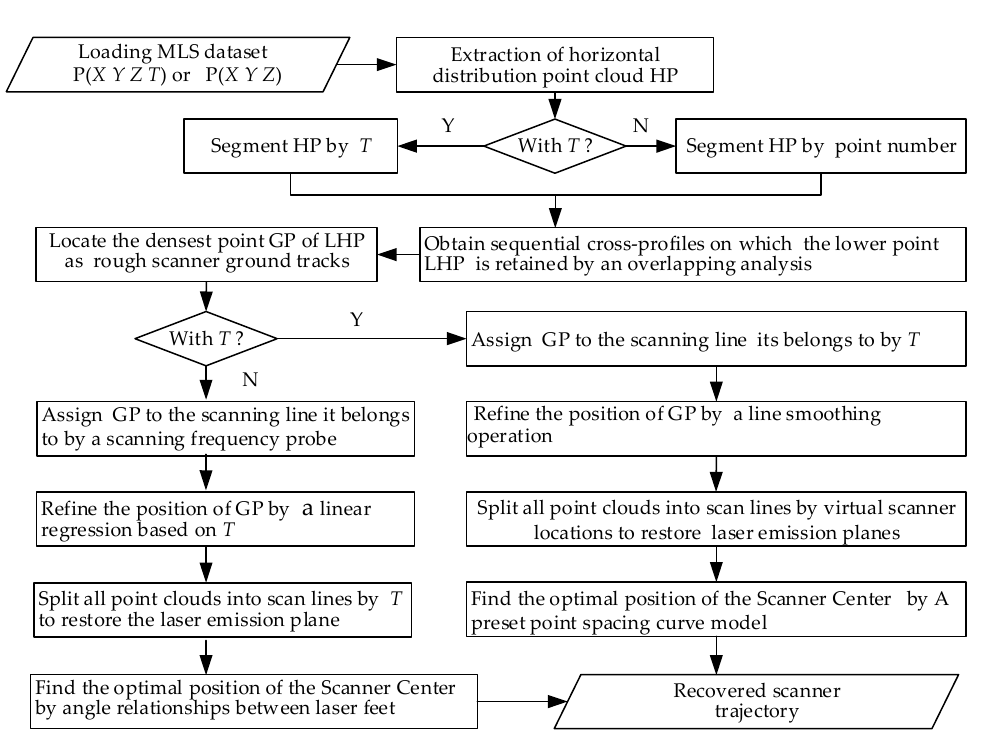
Figure 1. The flowchart of the process of recovering the scanner trajectory from mobile laser scanning (MLS) point cloud data: P( X , Y , Z , T ) or P( X , Y , Z (MLS) point cloud data: P(X,Y,Z,T) or P(X,Y,Z).